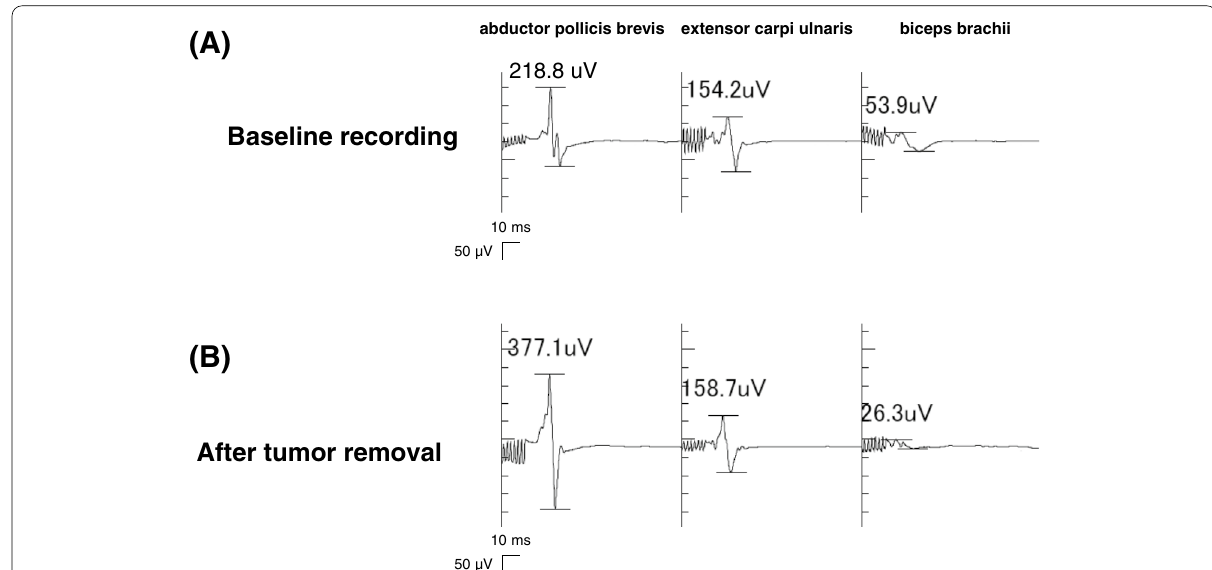
Fig. 1 MEPs from the left upper extremities upon direct cortical stimulation at the baseline recording ( A ) and after the tumor removal ( B ). The numbers superimposed show MEP amplitude. Stable myogenic MEPs were recorded throughout the surgery ( A , B ) with intravenous infusions of remimazolam at 0.9 mg/kg/h and remifentanil at 0.35